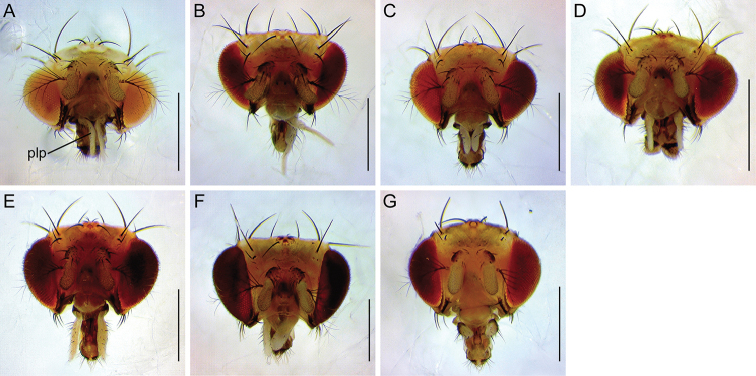
Head (anterior view). Amalayana (Takada) (#03903) Bgracilipalpis sp. n. (paratype #00492) Cpuberula sp. n. (paratype #03366) Dalbipalpis sp. n. (holotype #03908) Eqiongzhouensis sp. n. (paratype #03313) Forthophallata sp. n. (paratype #03905) Gdissimilis sp. n. (holotype #00430). Abbreviation: plp = palpus. Scale bars: 0.5 mm.